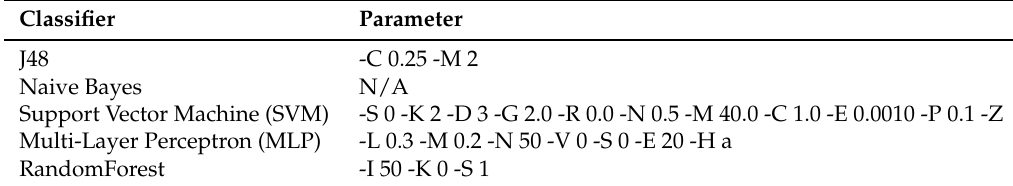
Table 6. Classifier parameters in Weka.